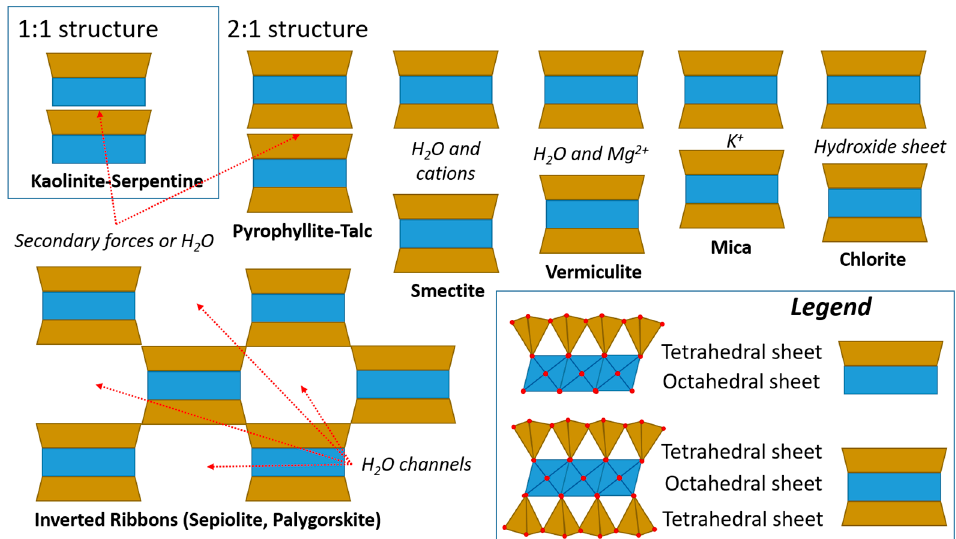
Figure 1. Schematic representation of 1:1 (inset) and 2:1 clay structures with a classification of the different subgroups of clays based on their stacking sequences. The difference in term of interlayers distance between the different subgroups of clays is comparable with the real one and depends on the species involved at the interface between the layered units. Reprinted with permission from [2].